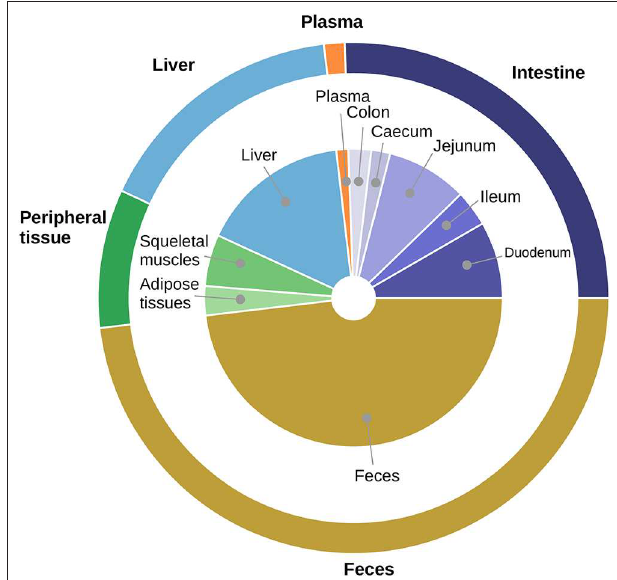
FIGURE 1 | Averaged distribution of labeled cholesterol in mice. The proportion of D5 labeled cholesterol in each compartment 3 days after ingestion is displayed. We obtained the average amount ( n = 3) of cholesterol in each compartment by GC/MS with internal standard (see section Materials and Methods). During experiments, cholesterol distribution was measured with a finer granularity than in the mathematical model: the central pie chart represents the distribution among the different compartments measured experimentally whereas the external pie chart indicates the corresponding distribution compartments represented in the mathematical model. The external pie is obtained by pooling the corresponding sub-compartments sampled during experiments. We observed that half of the labeled cholesterol ended up in the feces, while about one quarter remained in the intestinal